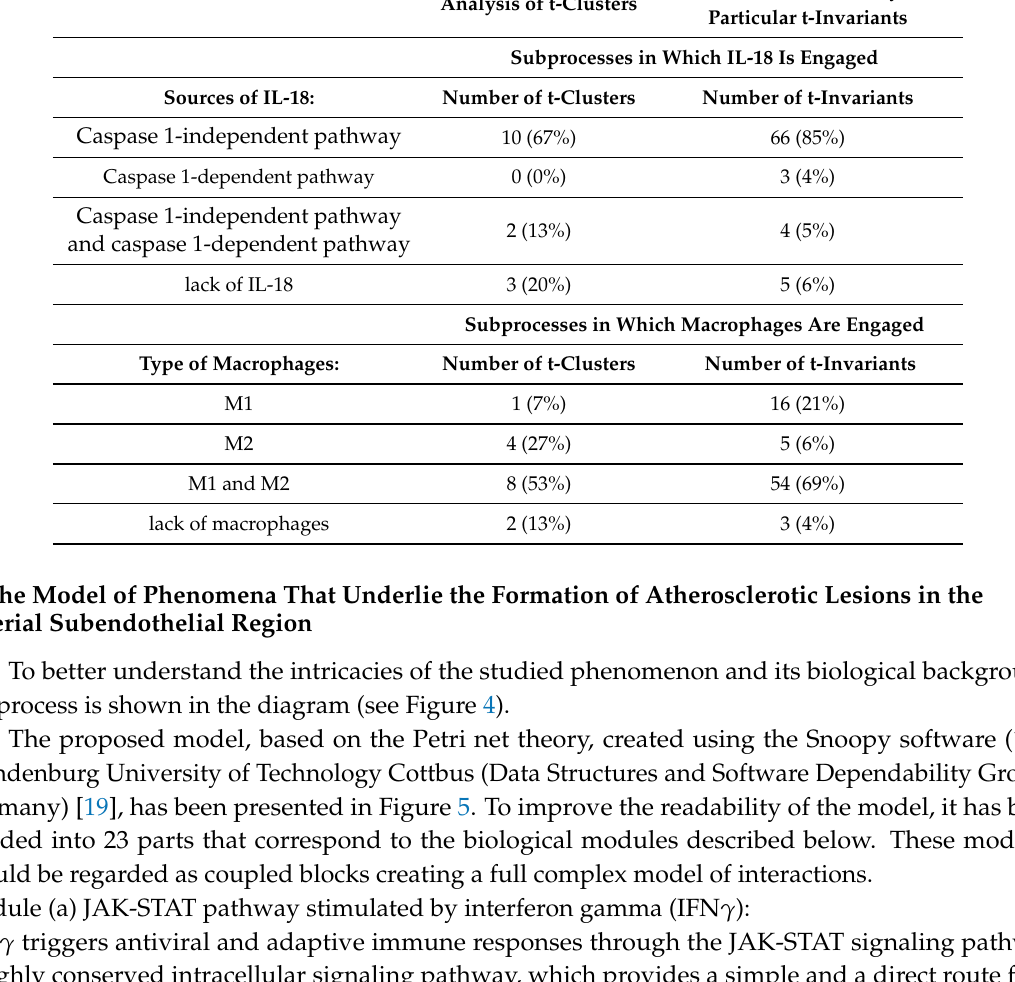
Table 3. Comparison of t-clusters analysis and the more detailed analysis of particular t-invariants in terms of occurring of IL-18 and macrophages in subprocesses. The More Detailed Analysis of Analysis of t-Clusters Particular